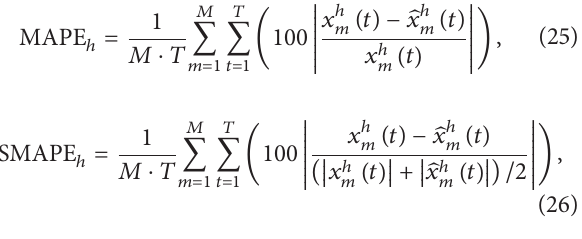
dimension 𝑑 of the best parameters combination (a particle) found so far in the swarm (𝑃) ; 𝑝 𝑔 = ⟨𝑝 𝑔1 , . . . , 𝑝 𝑔𝐷 ⟩ is considered as the global best ( gbest ) position. Note that each particle takes individual ( lbest ) and social ( gbest ) information into account for updating its velocity and